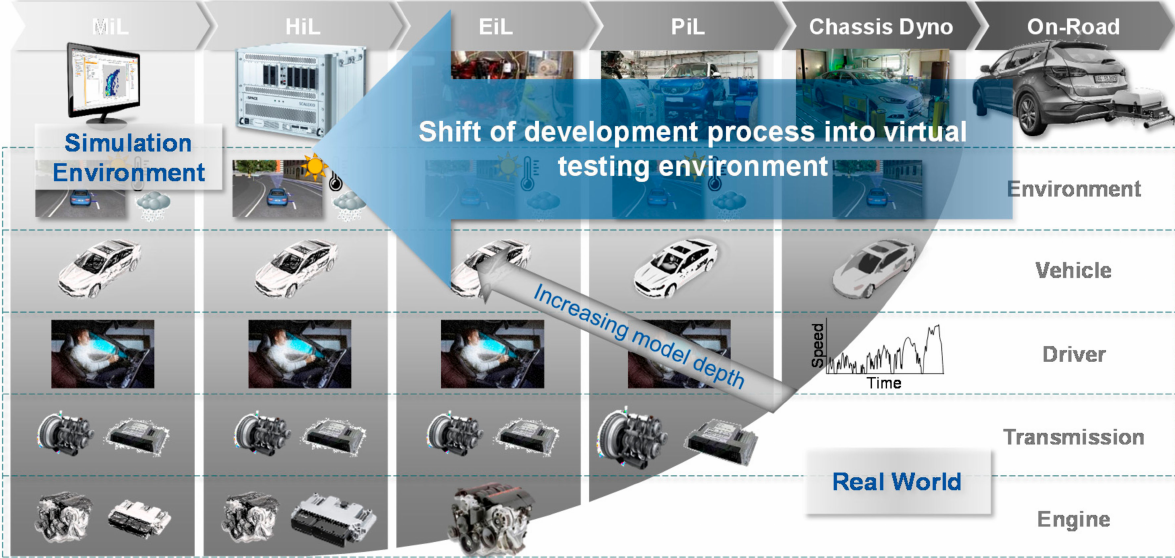
Figure 3. Overview of test beds and their degree of virtualization used for a holistic calibration and validation